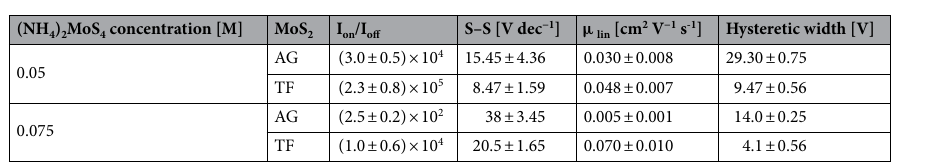
Table 2. Analytical results for hysteresis and other performance of TFT devices with concentration of precursor solution and transferring step (AG; as-grown, TF; transferred MoS 2